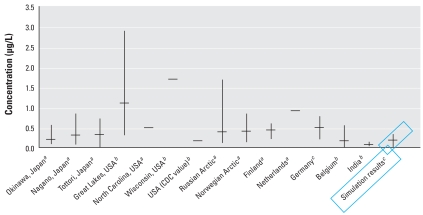
Mean and range of concentrations of PCB-153 in plasma (a), serum (b), and whole blood (c) of populations from worldwide geographic locations. Data from Covaci et al. (2002) for Belgium and Rusiecki et al. (2005) for India; all other data from Minh et al. (2006).